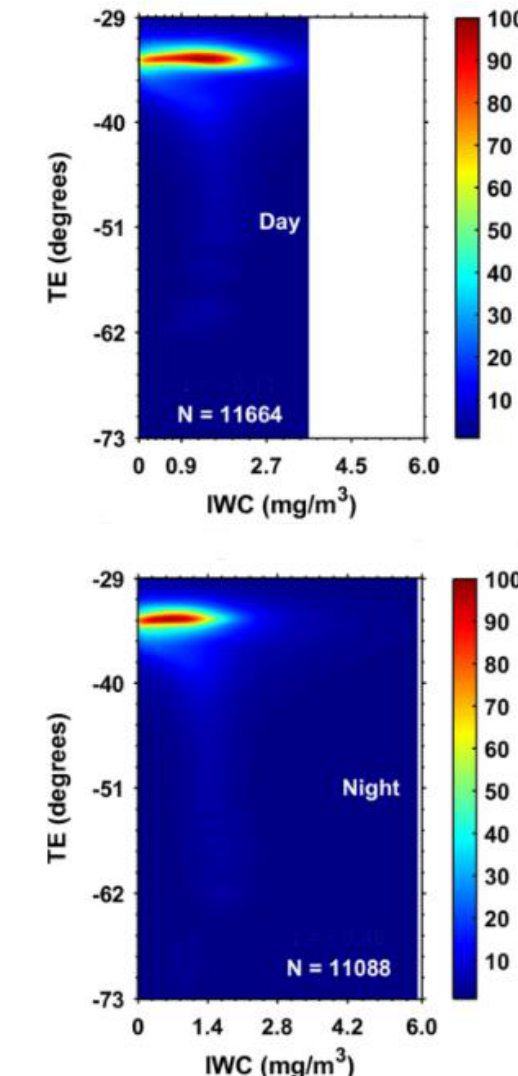
Figure 7. Relationships between average IWC and relative humidity (RH, left column) and temperature (TE, right column) during day and night in the globe based on the 10-year summertime measurements of CALIOP. The color bar represents the density of data distribution, and the white colors show no data.